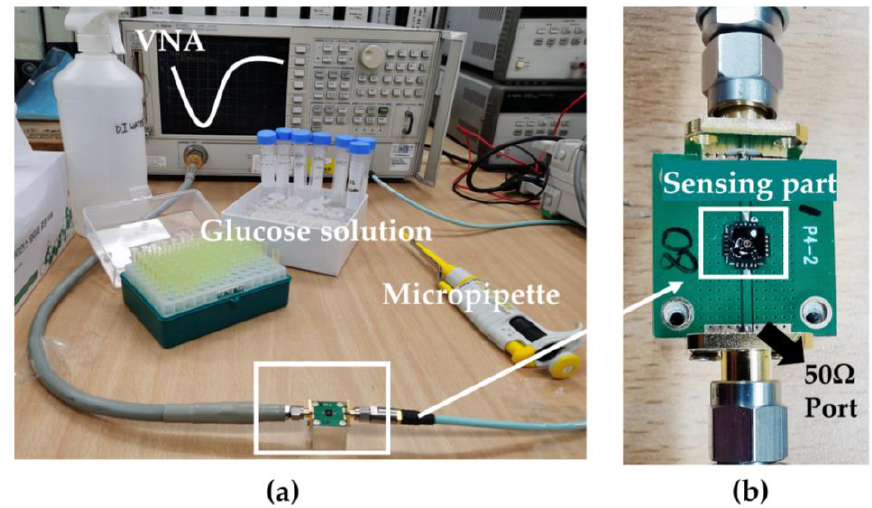
Figure 3. Experimental setup for the tests. ( a ) The experimental setup and preparation for the meas-urement of glucose level. ( b ) The tested device connected to a vector network analyzer (VNA) through a 50 Ω port.